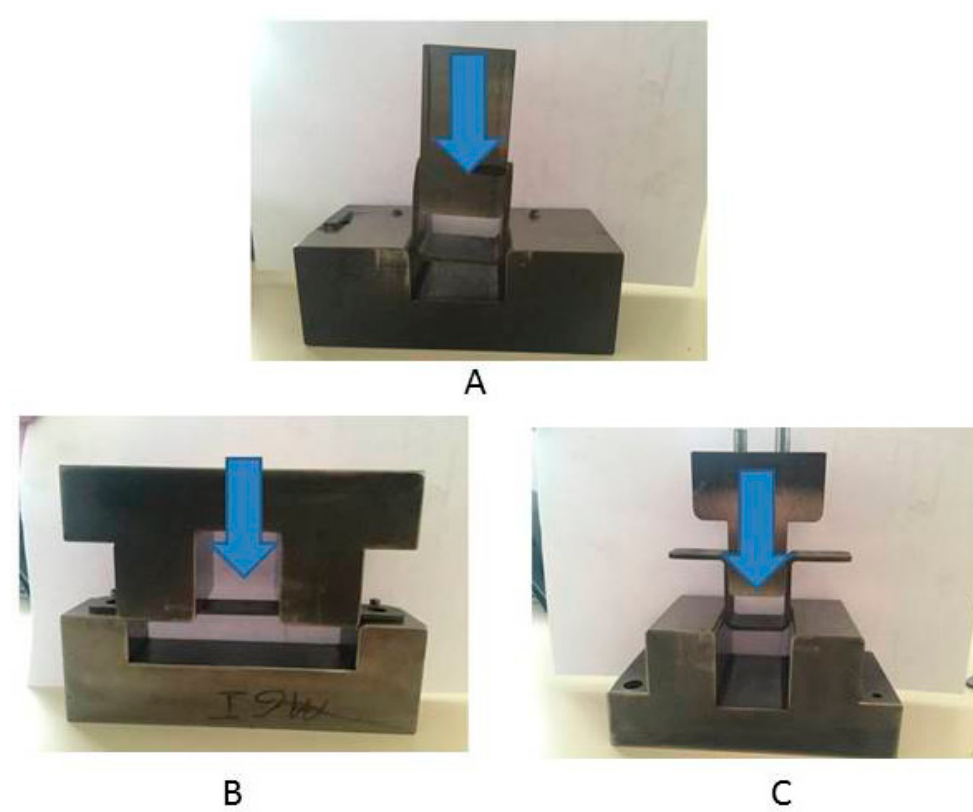
Figure 8. Prototyping steps of dummy door hinge (( A ) bending operation of fix leaf, ( B ) first bending operation of mobile leaf for assembly surfaces, ( C ) final bending operation of mobile leaf).